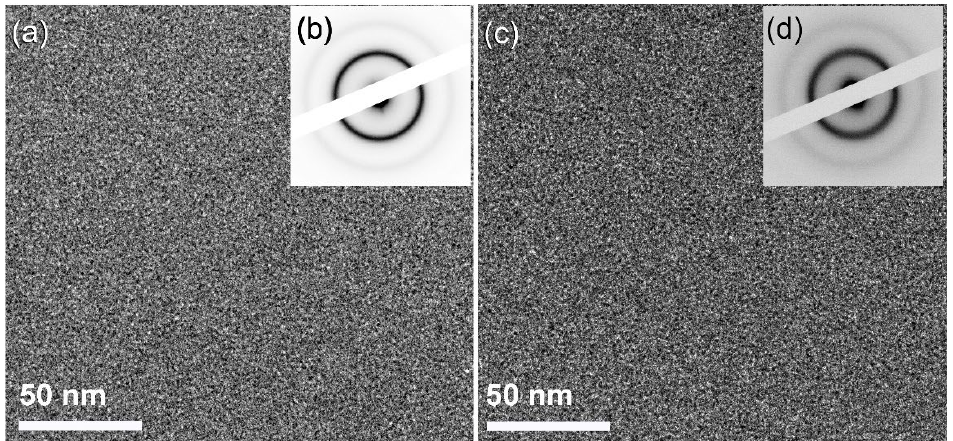
Figure 8. Field-emission high-resolution transmission electron microscope (FE-HRTEM) of the metallic glassy powders after cold spray coating of SUS304 substrate for ( a ) Ni 50 Ti 50 and ( c ) Ni 50 Zr 50 systems. The corresponding nanobeam diffraction patterns (NBDPs) for both systems are displayed in ( b ) and ( d ), respectively.